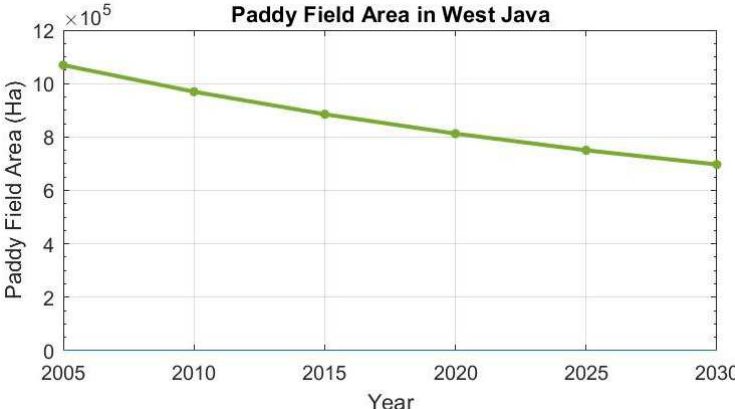
Figure 5. Graph of the decreasing paddy field area from year to year. Table 3. Decrease in the paddy fields area from year to year.